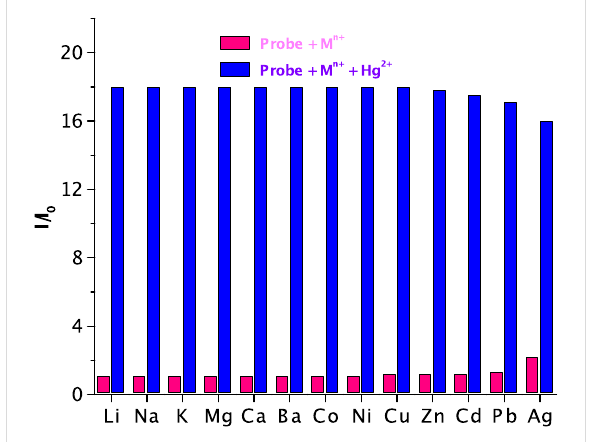
Figure 6: Fluorimetric response of acrithion 2 (2.5 × 10 − 6 M) in the presence of background metal ions (2.5 × 10 − 4 M each) in red and after addition of Hg 2+ (5.1 × 10 − 5 M) in blue.